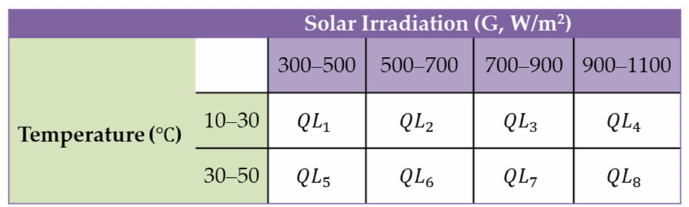
Figure 15. Block diagram of the proposed h-POQL MPPT method.